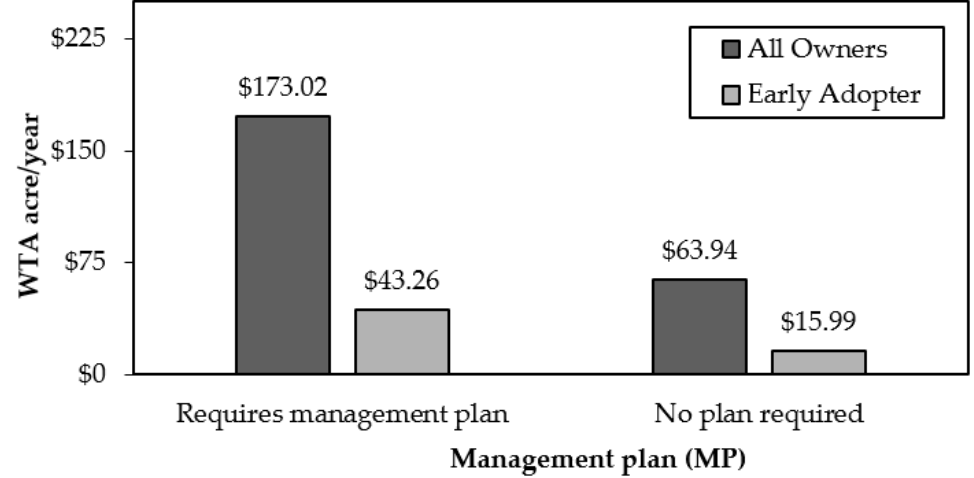
Figure 3. Willingness to accept payment for forest carbon if a management plan must be adopted (acre/year).